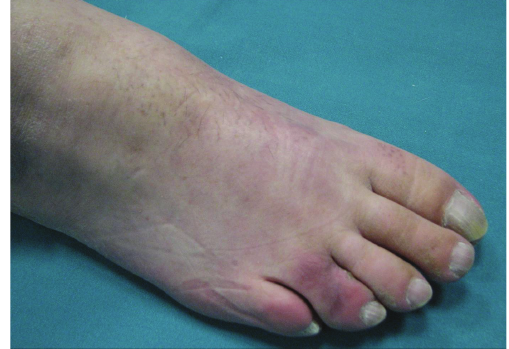
Figure 5: Clinical follow-up at one